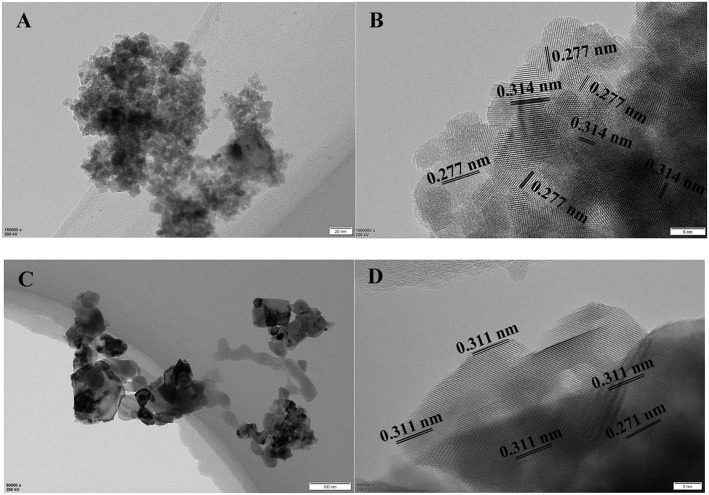
(A) TEM and (B) HRTEM images of CuO/CeO2, (C) TEM and (D) HRTEM images of CeO2.